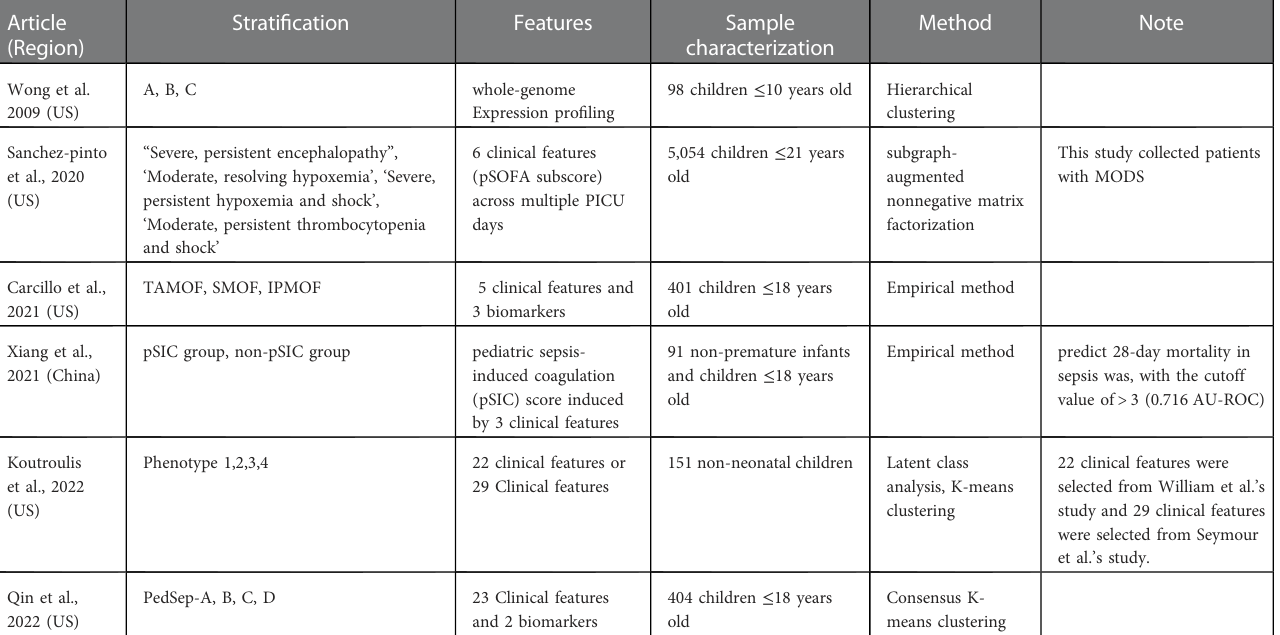
TABLE 2 Empirical and machine-learning-based phenotypes of pediatric